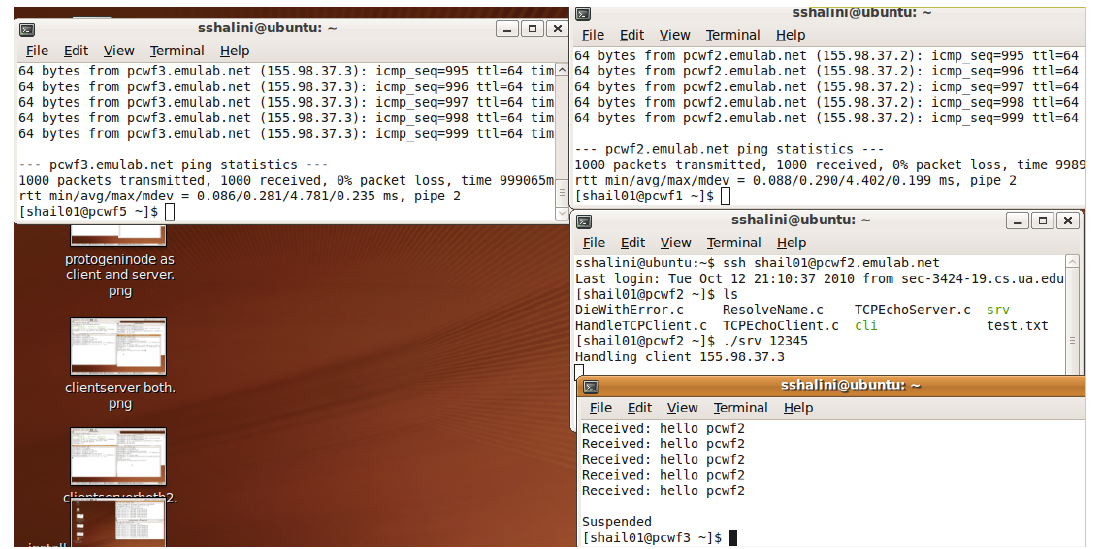
Fig. 17: Emulab topology for wireless nodes